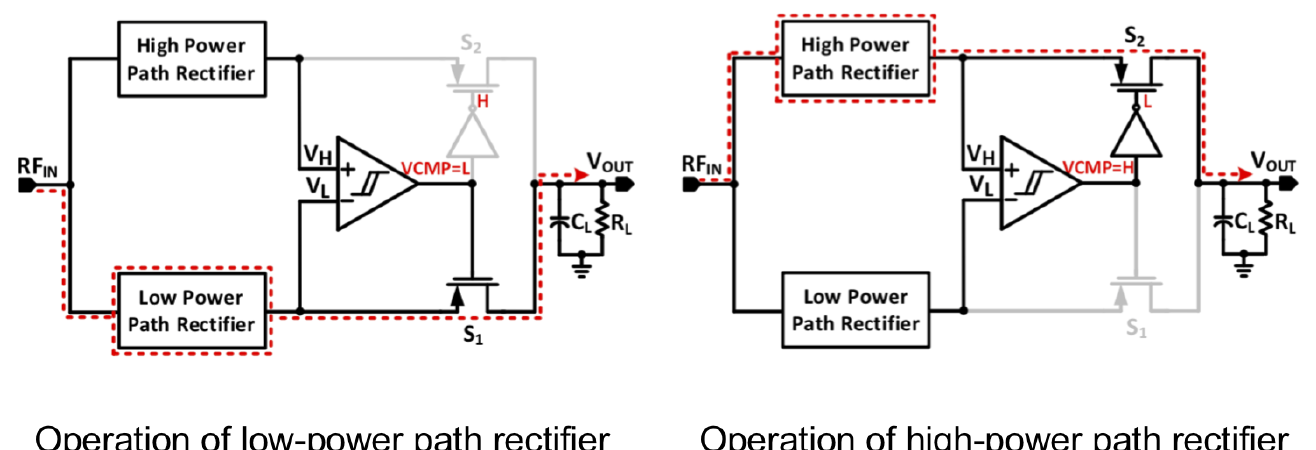
Figure 19. The RF-DC converter proposed in [43].